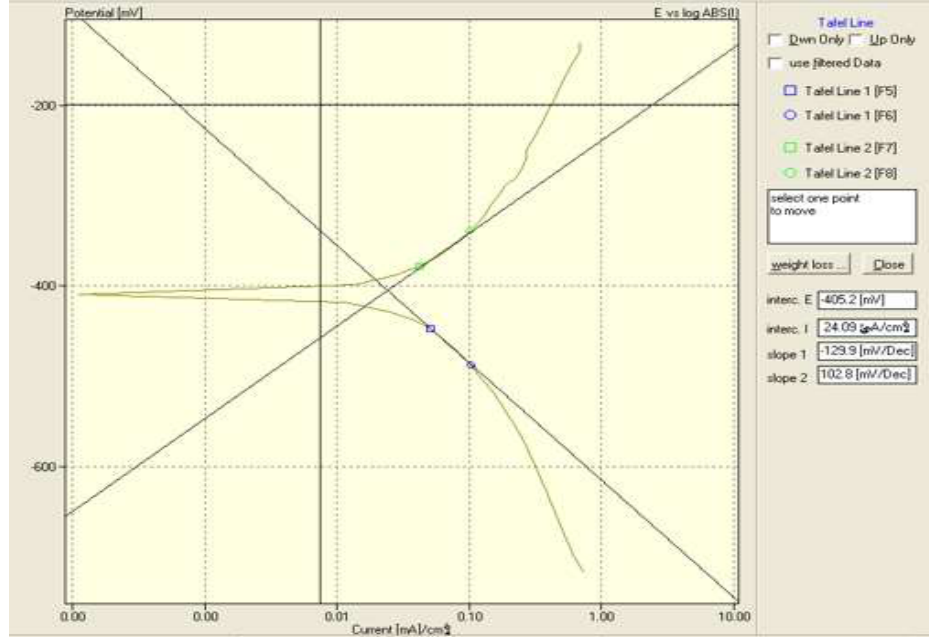
Fig.1: Polarization curve for copper before LST at 25 𝒄 ⃘ and